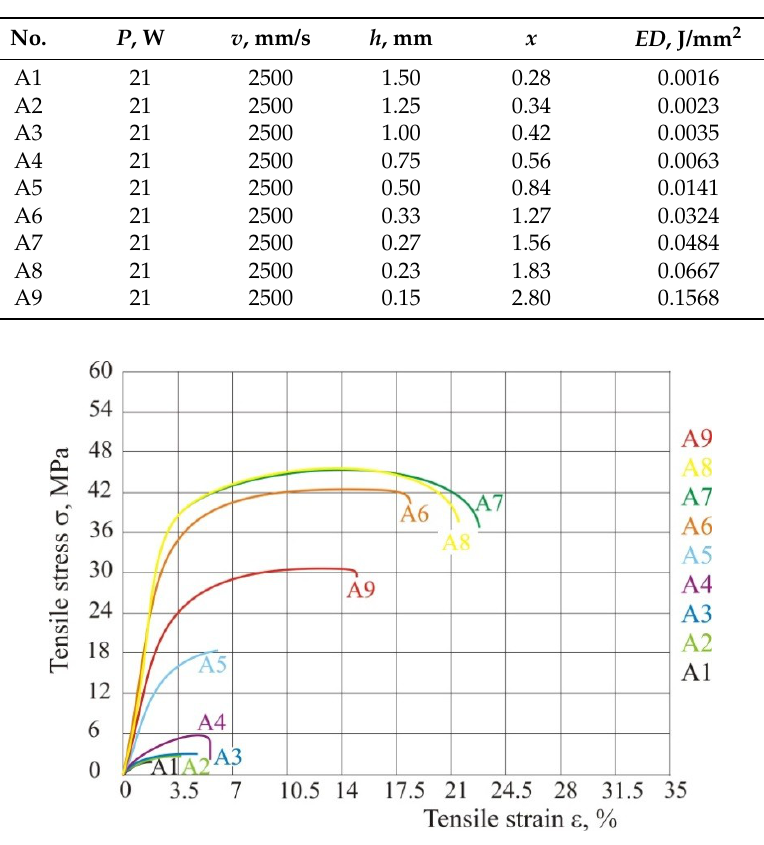
Table 6. Conformation of new equation.